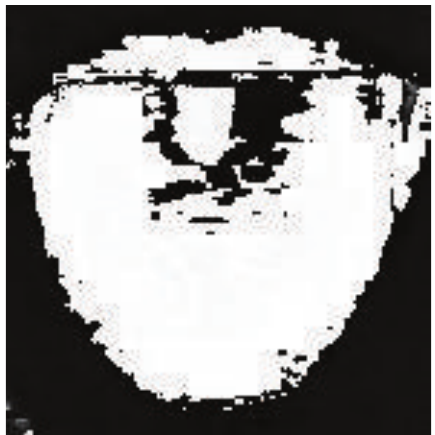
Figure 3: Grayscale image of tongue.